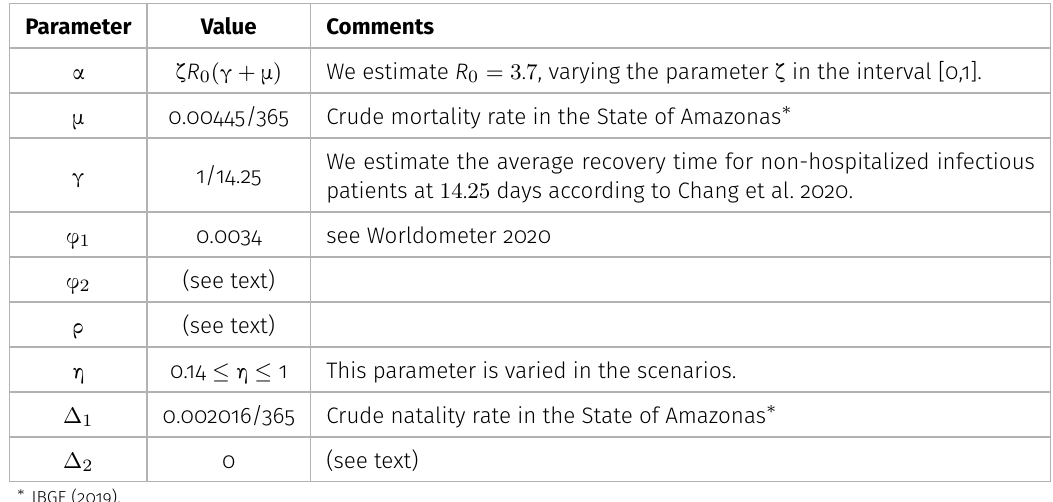
Table I. Parameter